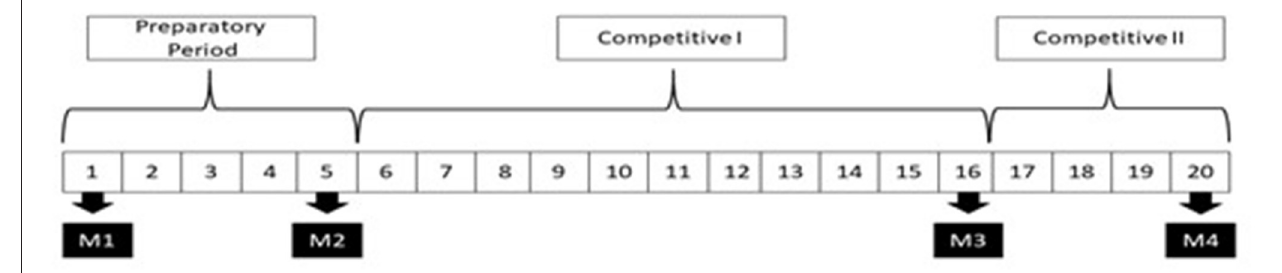
FIGURE 1 | Periods of training and assessment.